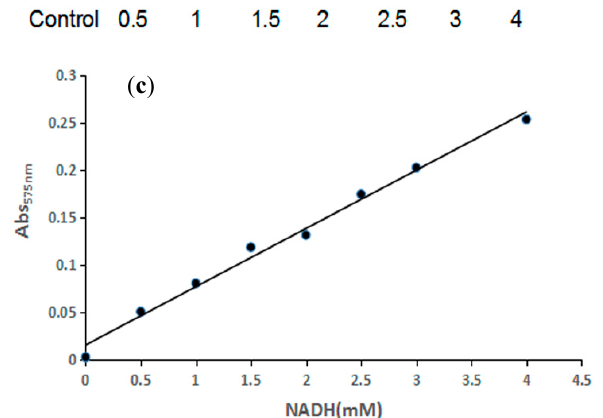
Figure 1. Development of the HTS method. ( a ). Principle of the HTS method. MTT, thiazolyl blue tetrazolium bromide; PMS, phenazine methosulfate. ( b ). The color variance of reaction mixture containing different concentrations of NADH. ( c ). The linear range of the measurement.